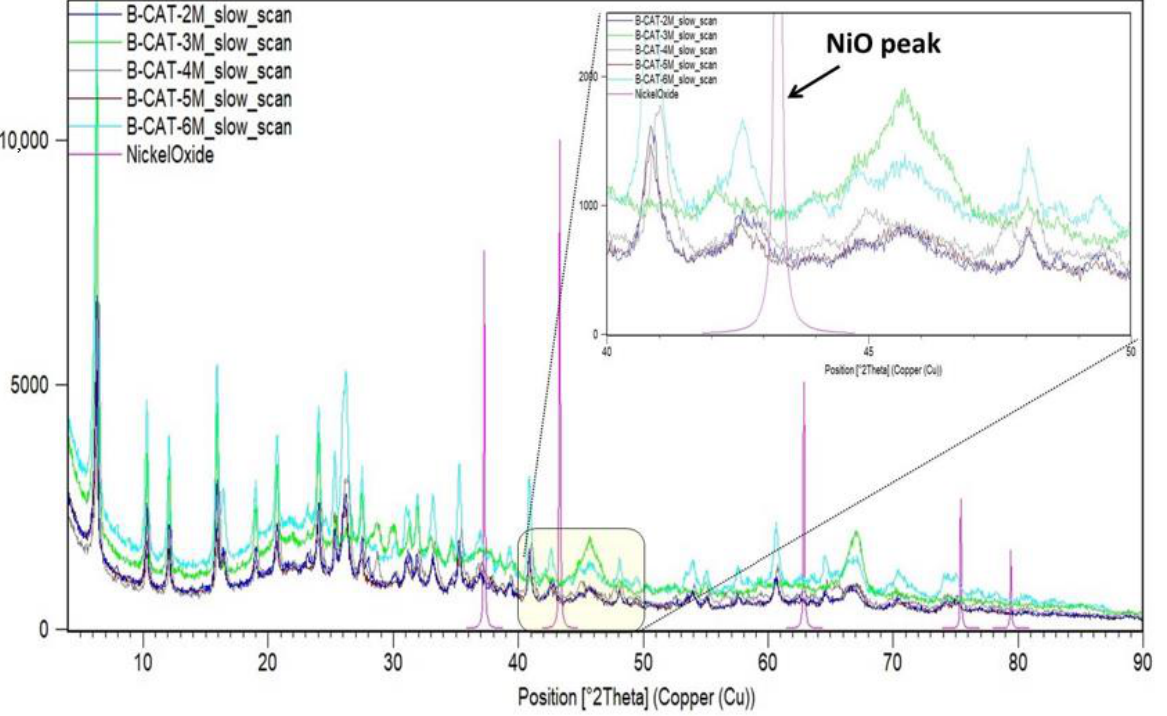
Figure 9. PXRD patterns of the Ecat (equilibrium FCC catalysts) samples with a total Ni content in the range of 1300 to 5140 ppm Ni. The pattern of NiO is also included for comparison. The inset figure focuses on the 2 θ region of 40 to 50° which includes the most prominent reflection of NiO, i.e., (2 0 0) at ~43.3°.